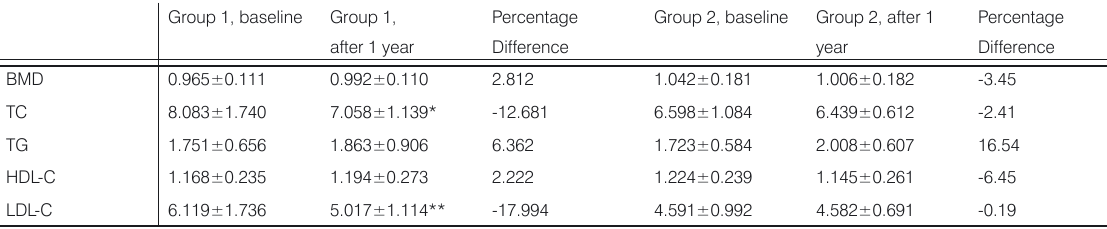
Table 3. Changes in BMD values and lipid parameters in each study group, after one year treatment.